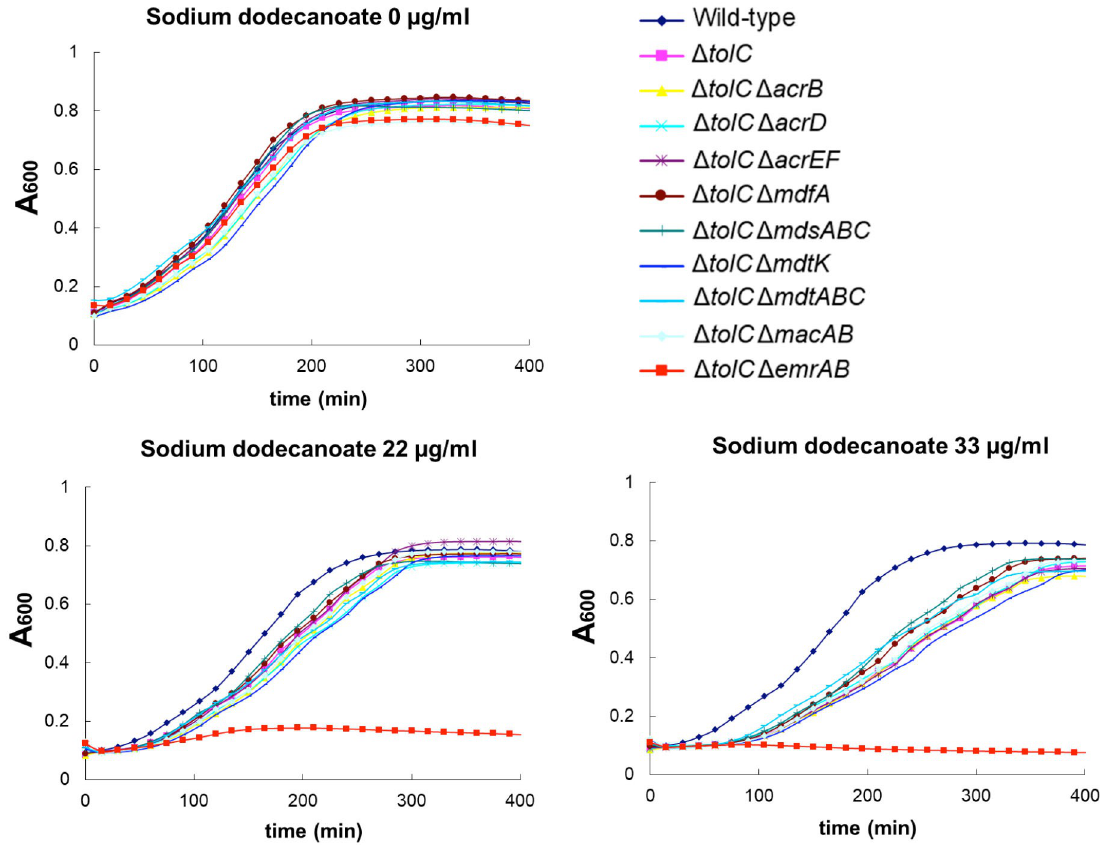
Fig 4. Effect of deletion of drug efflux genes from the tolC mutant on the growth of S . enterica in the presence of sodium dodecanoate. The growth of the wild-type and tolC mutant of S . enterica strains with the deletion of the multidrug efflux transporter gene were measured with or without sodium dodecanoate at concentrations indicated. Shown is the result of one of the three experiments, which gave similar results.